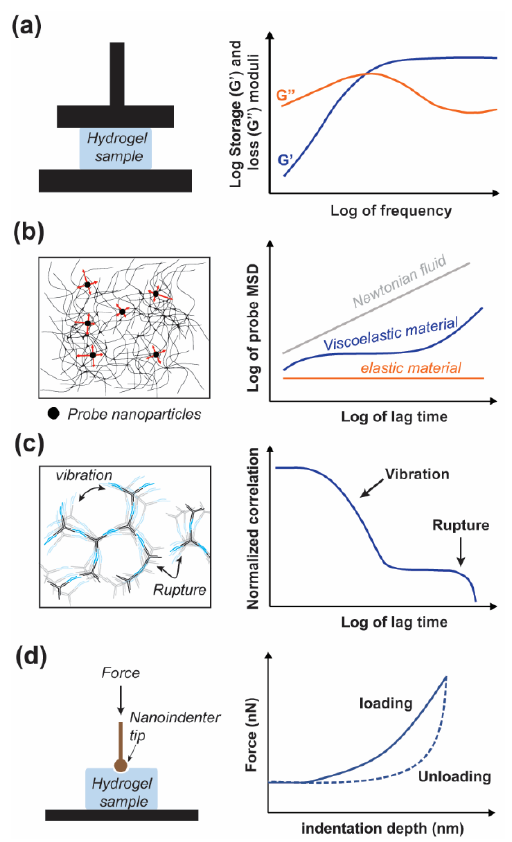
Figure 4. Common characterization methods for DNA hydrogel. ( a ) Bulk rheology and dynamic moduli. ( b ) Graphical depiction of microrheology showing constrained probe particle diffusion within the hydrogel network. The probe mean squared displacement (MSD) is used to determine the material behavior. ( c ) Network vibrations and interparticle hybridization rupture measured by dynamic light scattering (DLS) where a fast and slow decay time are observed and correspond to the timescale for each event, respectively. ( d ) Probe-based force controlled nanoindentation of DNA-based hydrogel to determine the material behaviors.